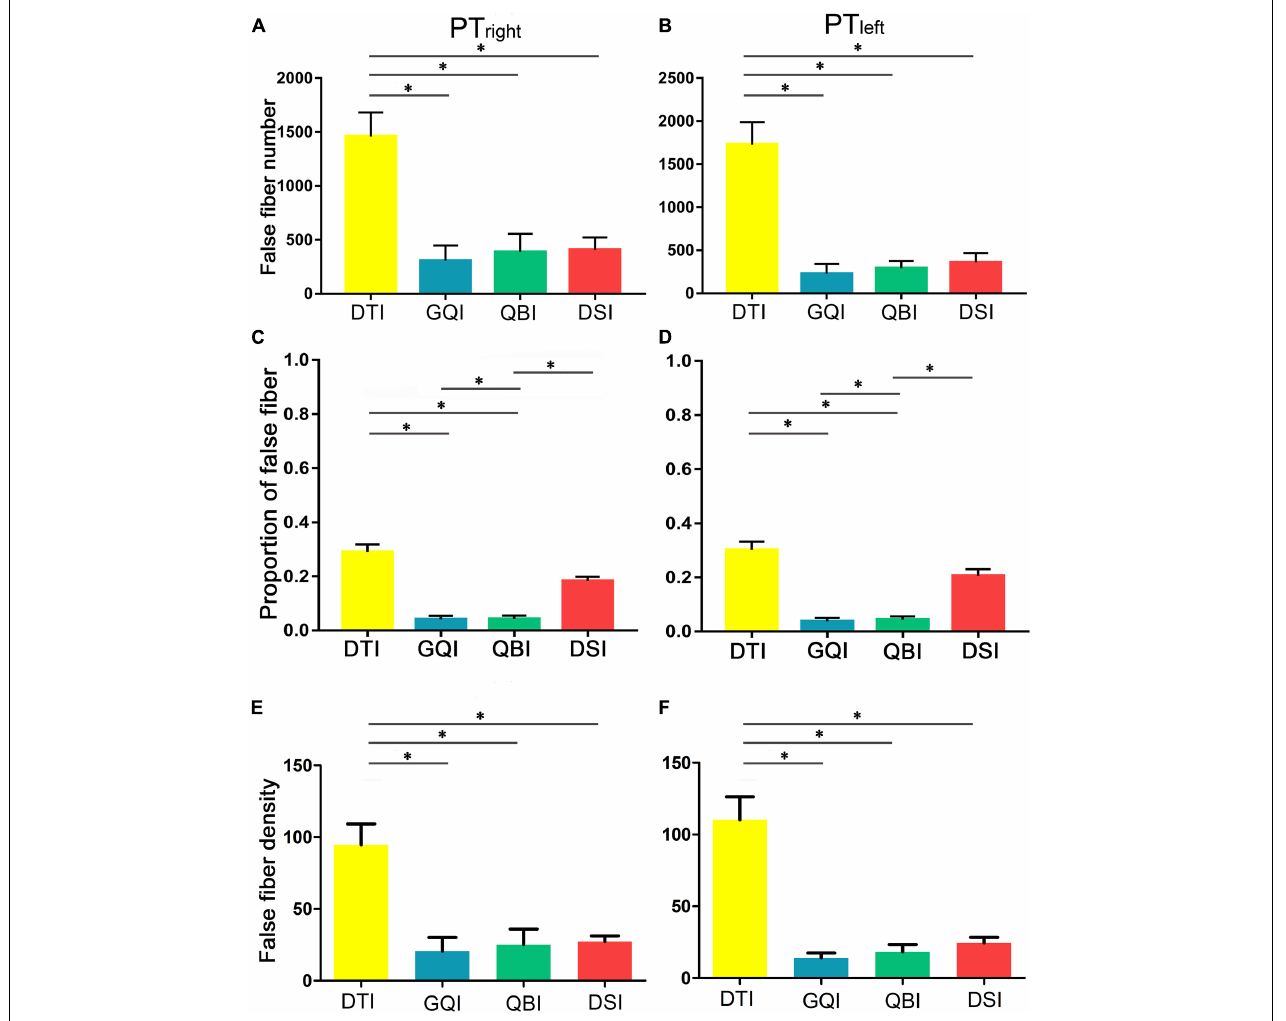
FIGURE 4 | Comparison of the false fiber number and density based on four diffusion models. (A) The false fiber number of the right PT. (B) The false fiber number of the left PT. (C) The percentage of false fibers of the right PT. (D) The percentage of false fibers of the left PT. (E) The false fiber density of the right PT. (F) The false fiber density of the left PT. DTI, diffusion tensor imaging; DSI, diffusion spectral imaging; GQI, generalized Q-space sampling imaging; L, left; PT, pyramid tract; QBI, Q-ball imaging; R, right. * represents p < 0.0005 (0.05/96, Bonferroni corrected). The error bar represents standard